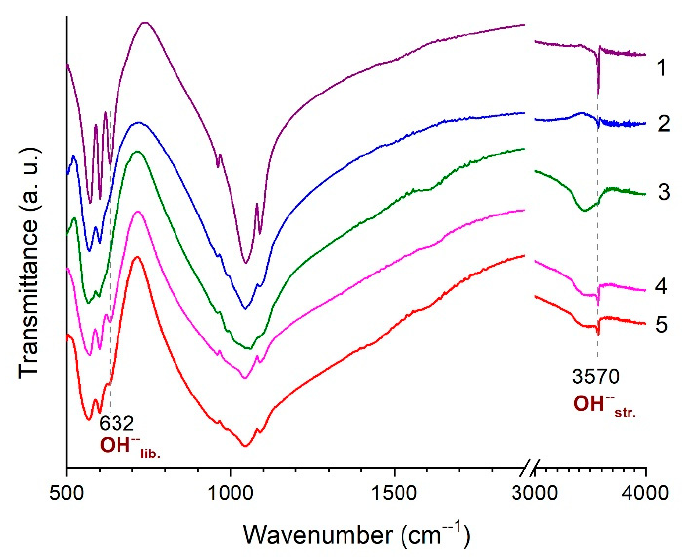
Figure 3. FTIR spectra of HA samples after sintering in a high-temperature furnace: (1) powder after after 1000 ◦ C during 2 h; (2) pellet after 1500 ◦ C during 10 min; (3) pellet after 1500 ◦ C during 2 h; 1000 °C during 2 h; (2) pellet after 1500 °C during 10 min; (3) pellet after 1500 °C during 2 h; (4) (4) powder after 1500 ◦ C during 10 min; (5) powder after 1500 ◦ C during 2 powder after 1500 °C during 10 min; (5) powder after 1500 °C during 2 h.